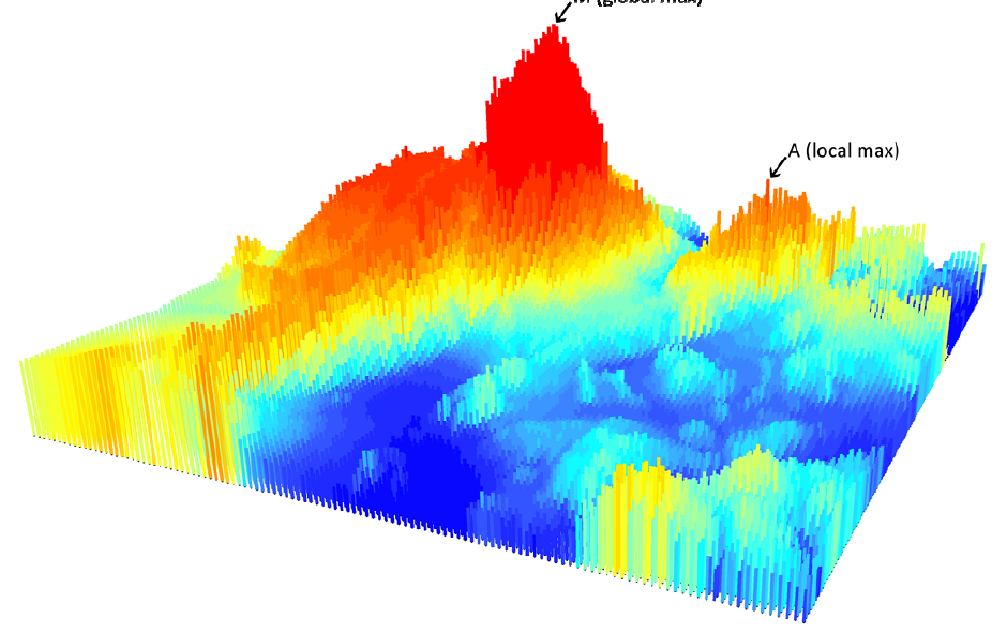
Figure 3. Hypothetical fitness landscape and outcome in the changed environment